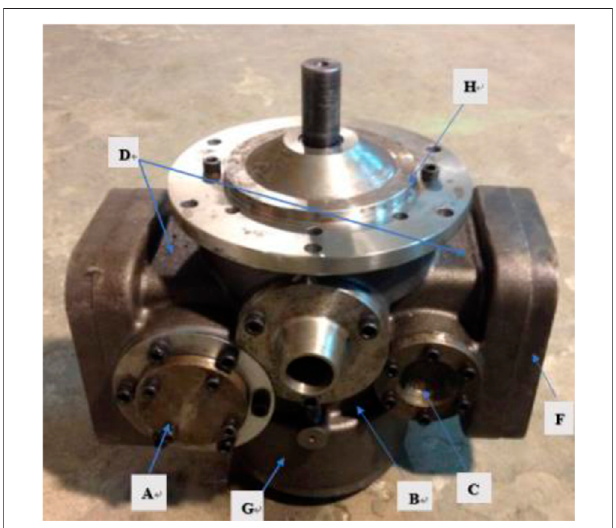
FIGURE 3 | Surface area division of expander casing.